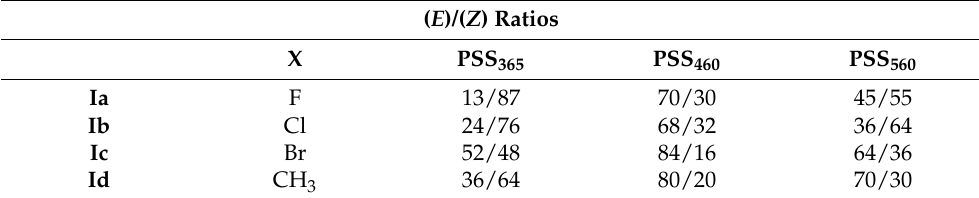
Table 2. Ratio of ( E ) and ( Z ) isomers in various PSS states in deuterochloroform solution at room temperature.